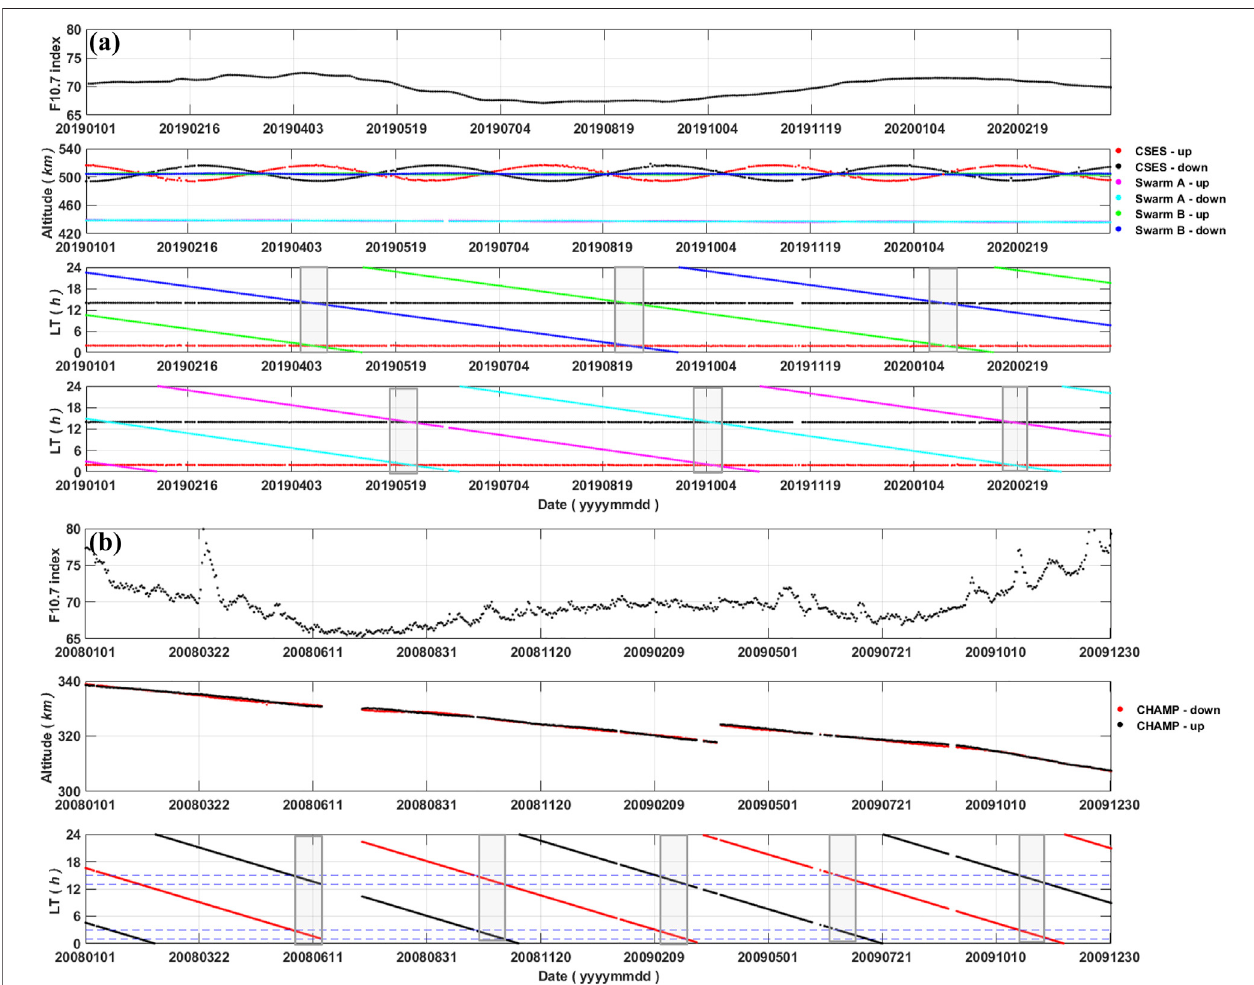
FIGURE 1 | The temporal variation of altitude, local time from four satellites and their corresponding solar fl ux. (a) for CSES, Swarm B, and Swarm A; (b) For CHAMP.